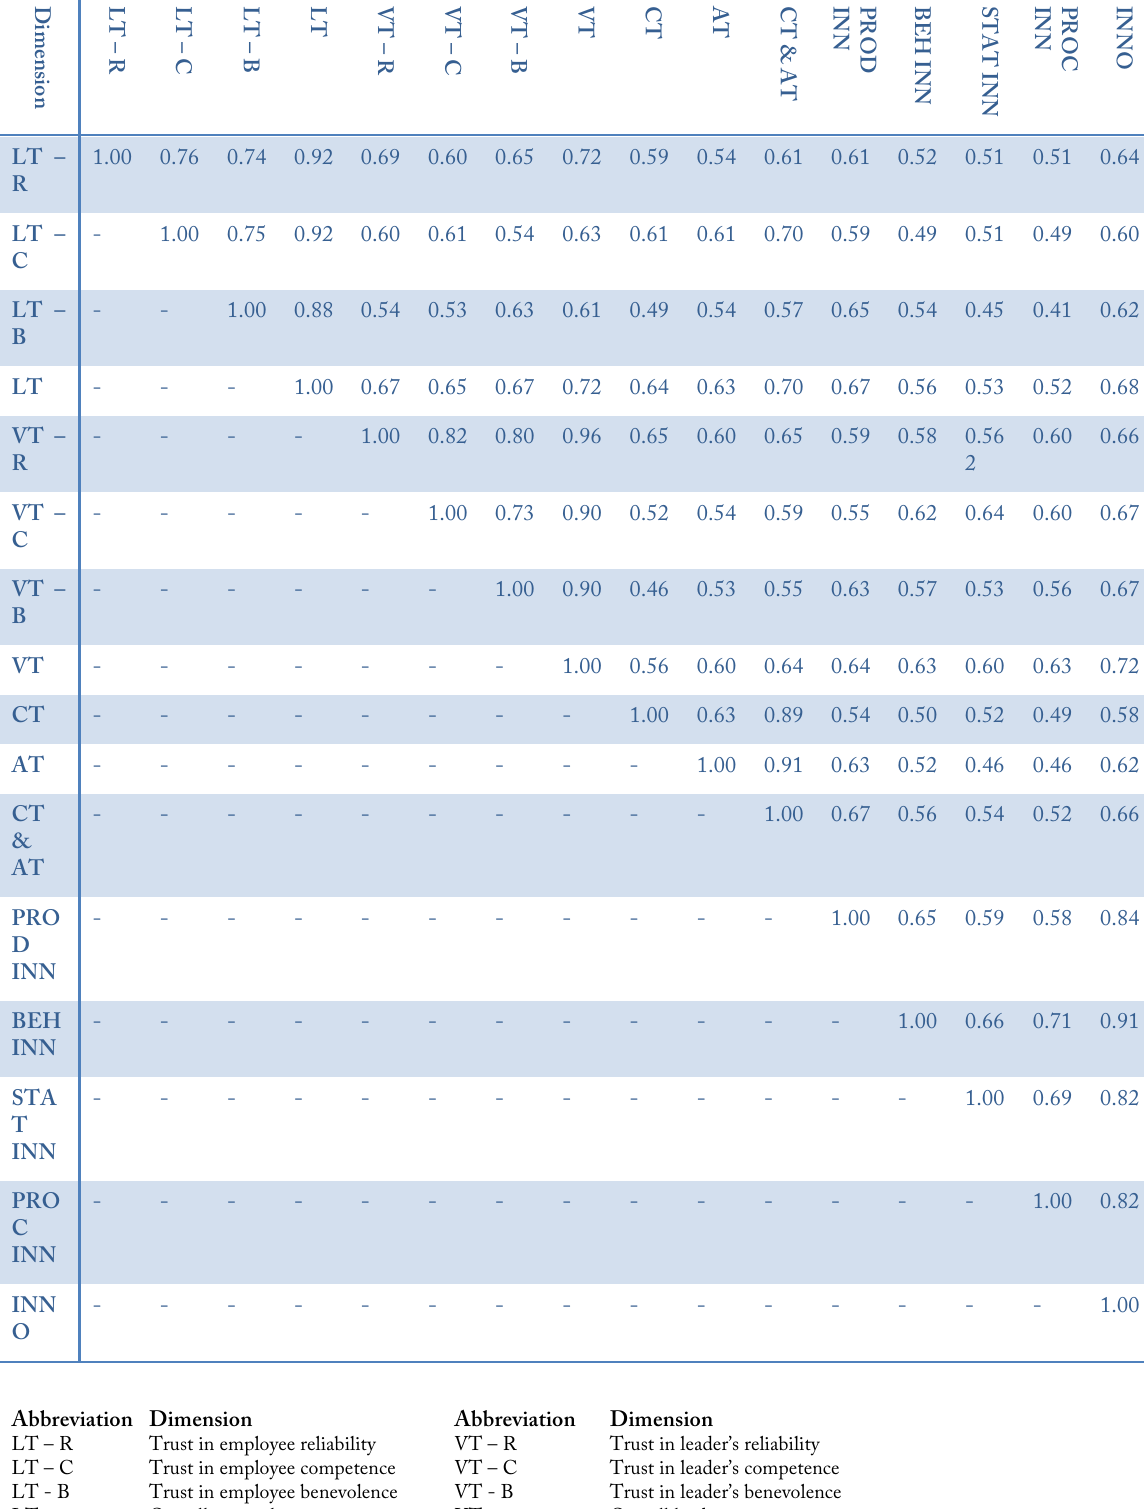
Table B1: Spearman’ rho correlations for interpersonal trust and organisational